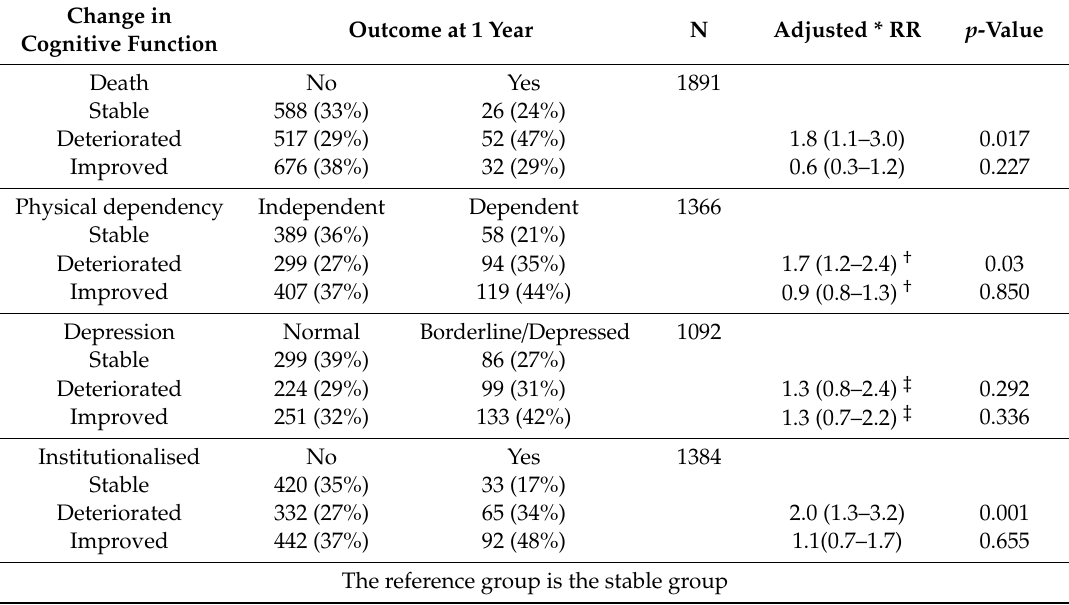
Table 5. One year outcomes by change in cognitive function between seven days and three